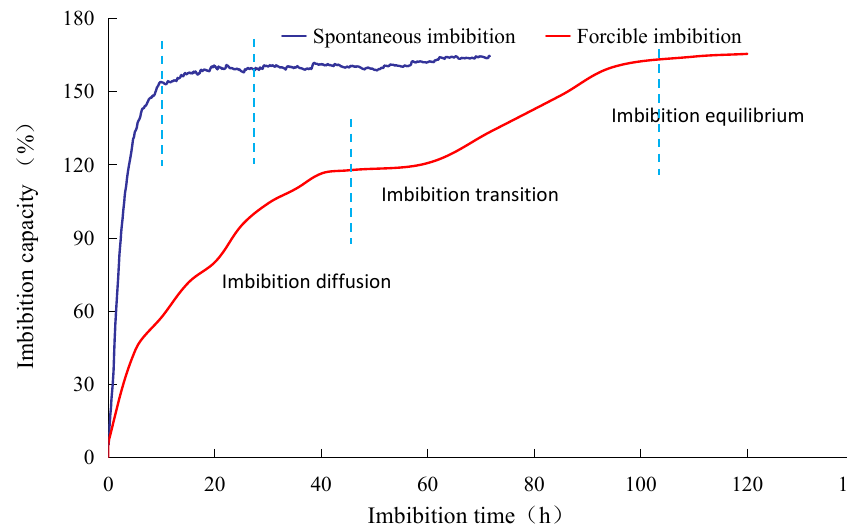
Figure 6. Comparison of imbibition capacities under different imbibition modes. The relationship curves between imbibition capacity and time for the six shale samples under different experimental conditions are shown in Figure 7. The curves show that the samples differed widely in imbibition capacity due to different experimental conditions and heterogeneity. At an imbibition time of 5 d, they had a maximum forcible imbibition capacity between 46.6 and 166.5% (112.4% on average). In the early stage of imbibition, the forcible imbibition capacity increased quickly. For example, at an imbibition time of 2 d, S3 and S4 had a maximum imbibition capacity of 116.7% and 77.1%, respectively. In the conventional spontaneous imbibition experiment of sample S7, the sample S7 quickly reached a state of equilibrium and had an imbibition capacity of 158.6% at an imbibition time of 1 d. In contrast, under the conditions of reservoir temperature and pressure, the other six samples did not reach an equilibrium state after quite a long time into the experiment. Clearly, at the early stage of shut-in the fracturing fluid would imbibe forcibly into the reservoir quickly, providing imbibition fluid for subsequent spontaneous imbibition to the shale matrix pores and natural fractures and further stimulating the shale reservoir through